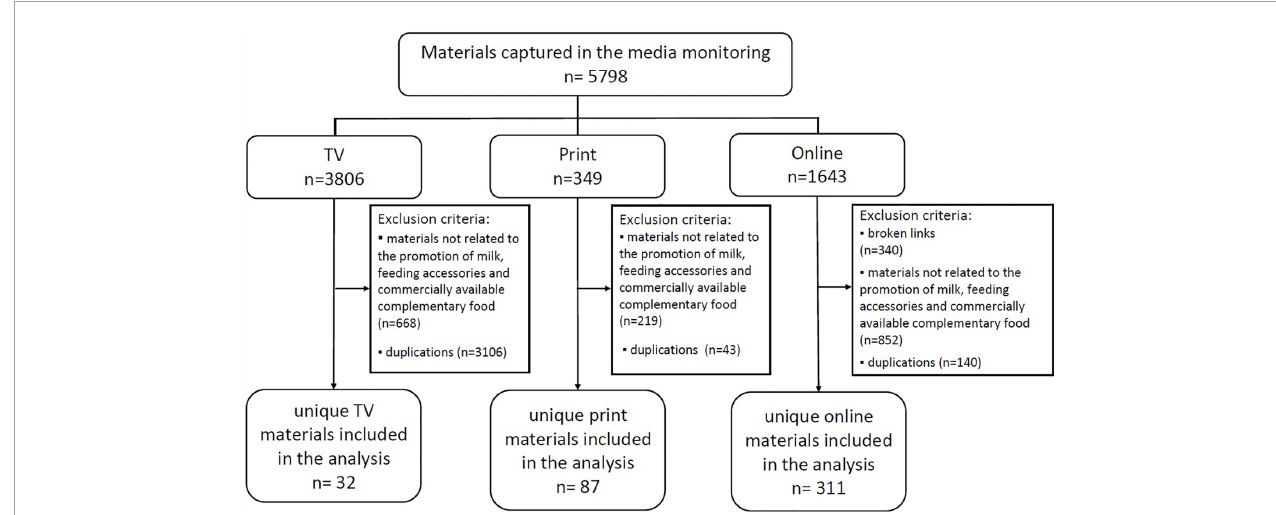
FIGURE1 Methods process flow for the identification of unique TV, printed, and online materials for detailed analysis.